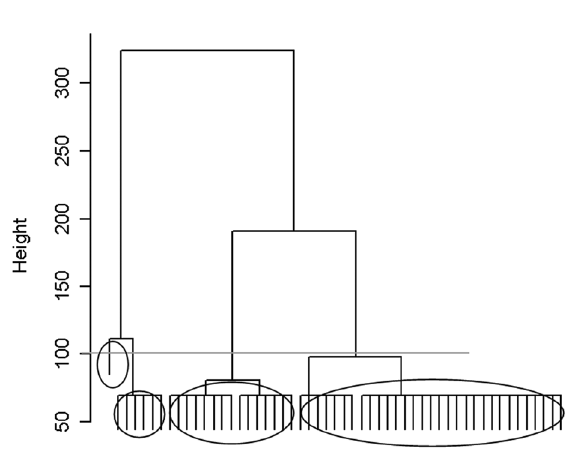
Table 3. – summary of the technical characteristics of Madeiran vessel subset used in fishing effort standardisation. loa, length- over-all; gt, gross tonnage; PoW, engine Fig . 3. – hierarchical cluster analysis dendrogram showing four groups of vessels, from the period 2005-2007, obtained using complete linkage agglomeration method and the chebychev dis- tance. this analysis comprised vessels from both the mainland and Madeira.